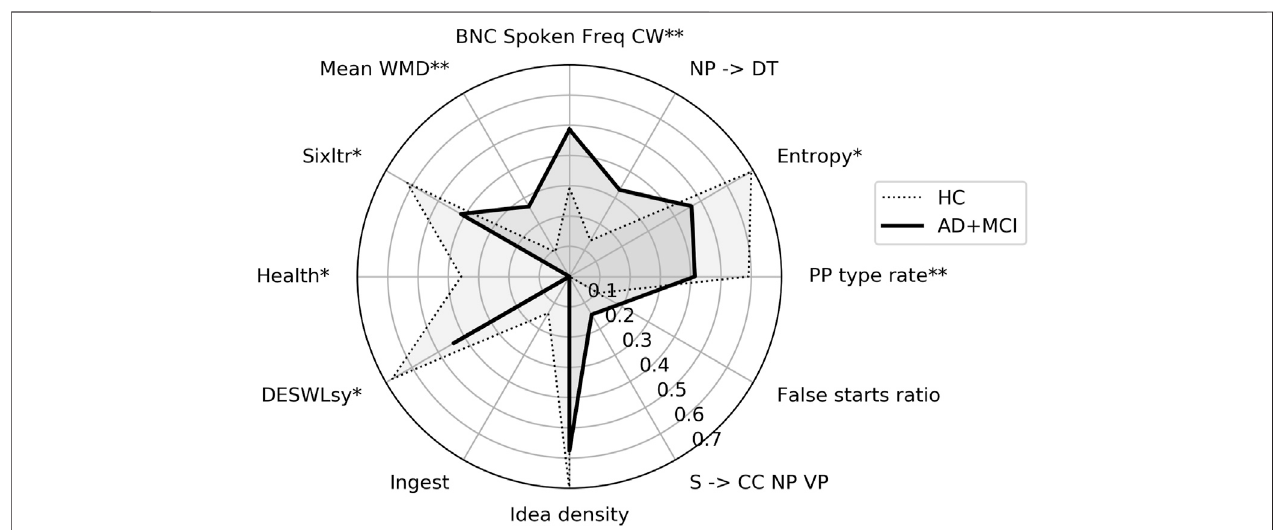
FIGURE1| RadarplotshowingfeaturesimportantforHCvs.AD+MCIclassi fi cationusingoverlearnednarrativerecall.HC (cid:1) healthycontrol,AD+MCI (cid:1) Alzheimer ’ s disease and Mild Cognitive Impairment group. Features have been scaled to between 0 and 1 using MinMax scaling and medians plotted. * (cid:1) p < 0.05, ** (cid:1) p < 0.001. Frontiers in Computer Science |